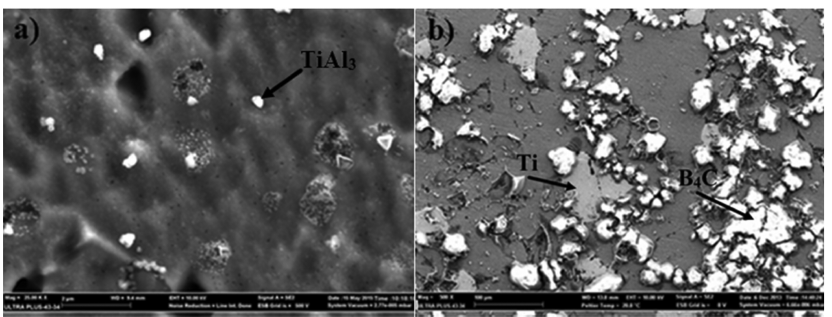
Figure 1: Microstructure SEM images of hybrid ACMs produced by adding 4% Ti (a) and 9% B 4 C